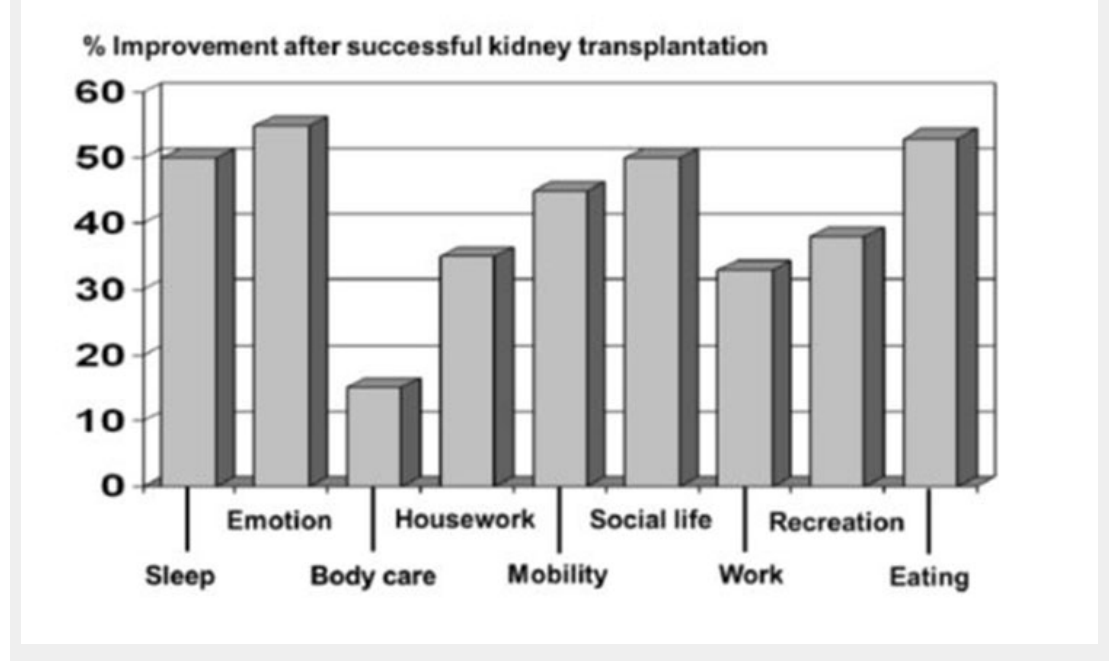
Figure 3 Changes in quality of life factors after successful kidney transplantation in patients previously undergoing haemodialysis. The Karnofsky Scale and the Sickness Impact Profile were used as indicators for quality of life (adapted from [46]: Jofre R, Lopez-Gomez JM, Moreno F, Sanz- Guajardo D, Valderrabano F. Changes in quality of life after renal transplantation. Am J Kidney Dis. 1998;32(1):93–100. With kind permission from Elsevier, Oxford,